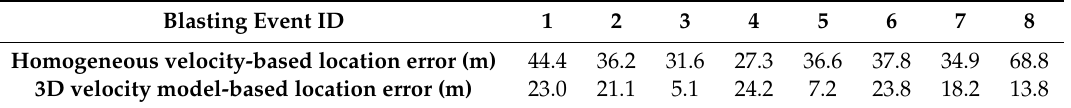
Table 2. Location errors (m) of the eight blasting events based on the GBRTM location method using the 3D velocity model and homogeneous velocity